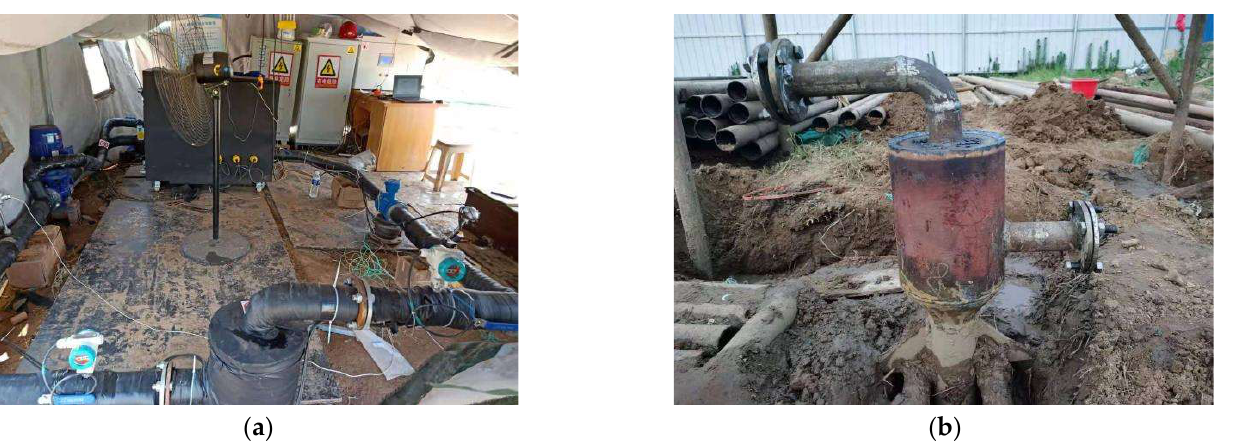
Figure 11. Schematic diagram of the thermophysical properties test. ( a ) The “inner tube in and outer tube out” configuration. ( b ) The “outer tube in and inner tube out” configuration.